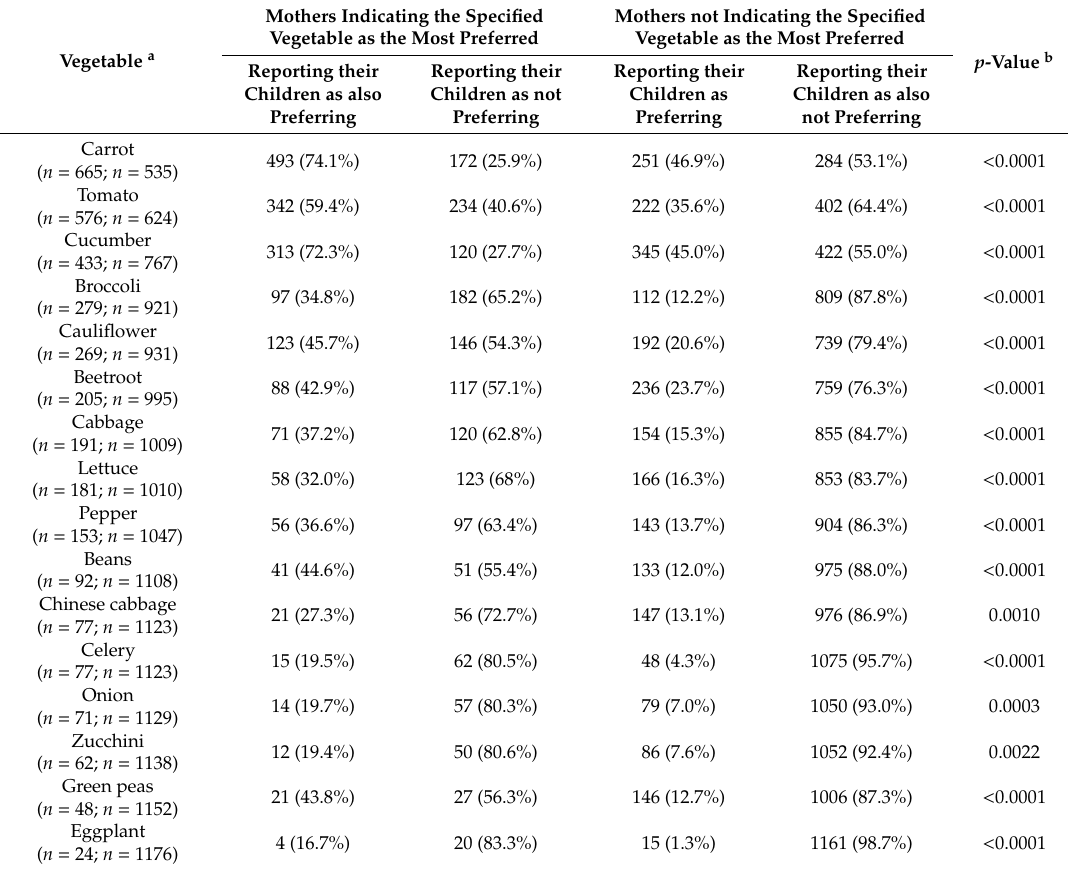
Table 5. Analysis of the association between the vegetable preferences self-reported by the mothers and reported by them for their children in a national representative sample of Polish mother–child pairs ( n =